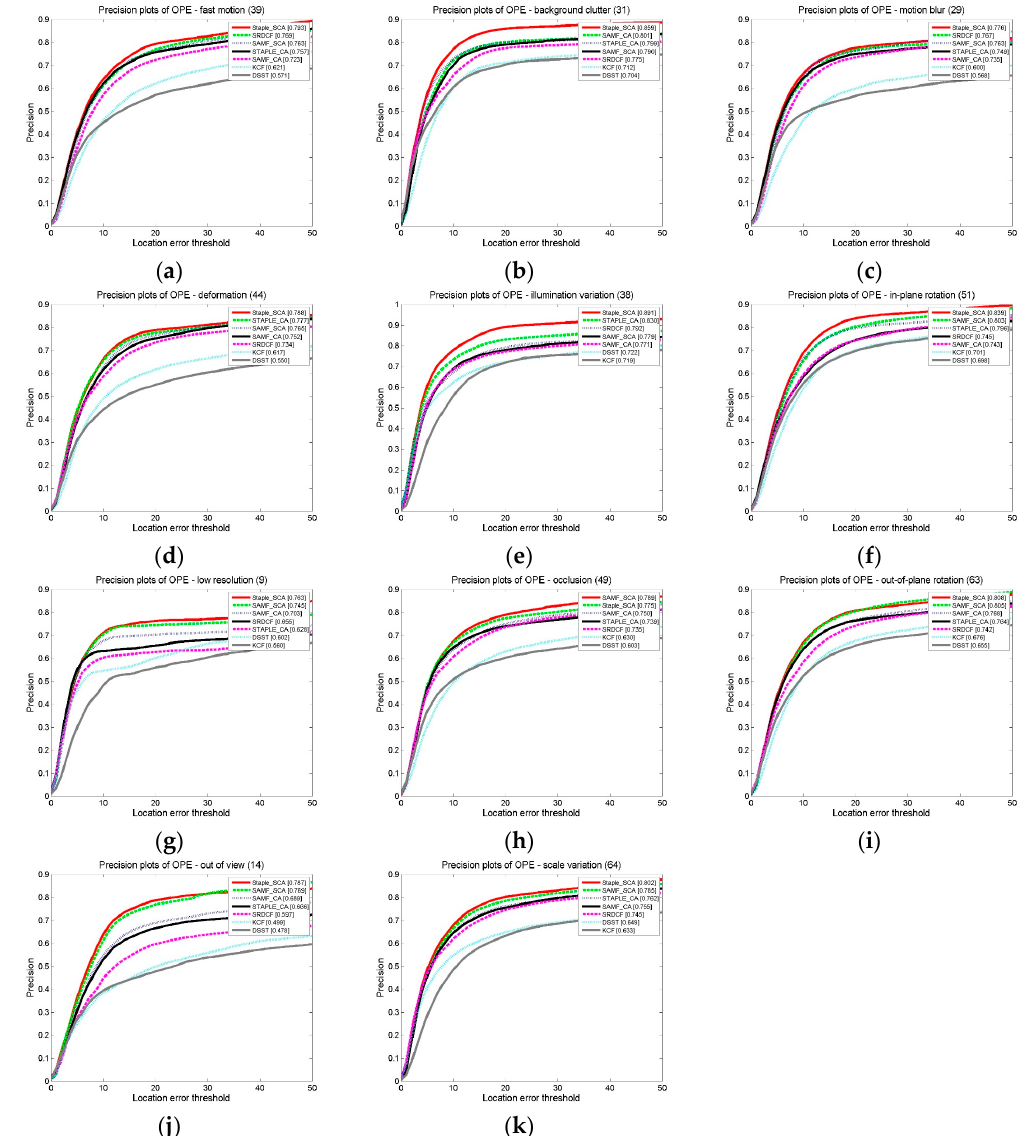
Figure 7. Precision plots over the default 100 video sequence in Visual Tracking Benchmark [8] for seven competing trackers under 11 challenging attributes. ( a )–( k ) indicate the precision plots of different sub-categories, respectively .